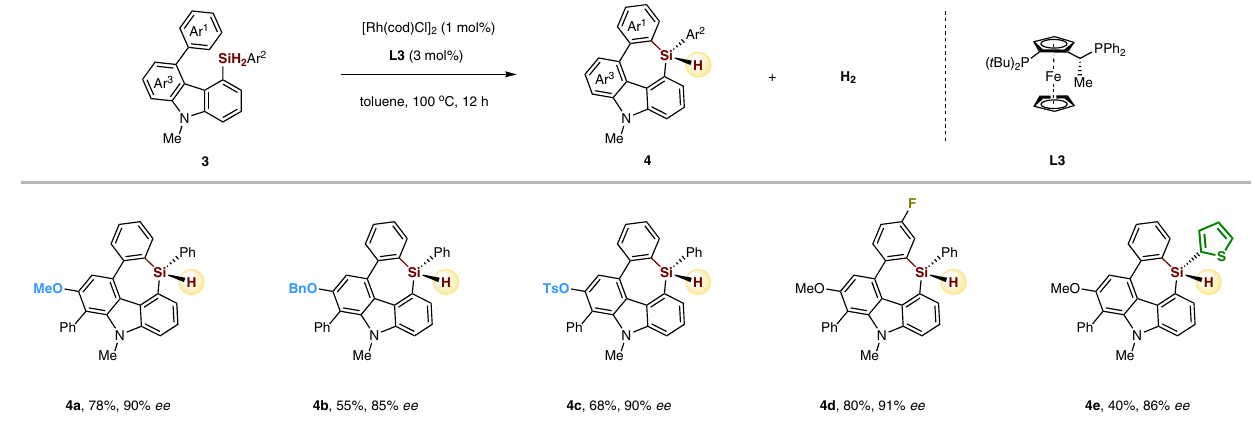
Fig. 4 Scope of seven-membered triorgano-substituted silicon-stereogenic heterocycles. Reaction conditions: 3 (0.1 mmol), [Rh(cod)Cl] 2 (1 mol%), L3 (3 mol%) in toluene (1 mL) at 100 °C for 12 h.